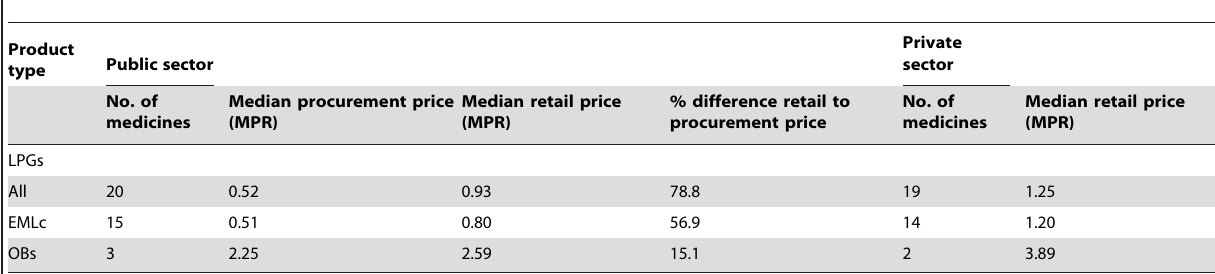
Table 2. Median MPRs for OBs and LPGs in the public and private sectors.